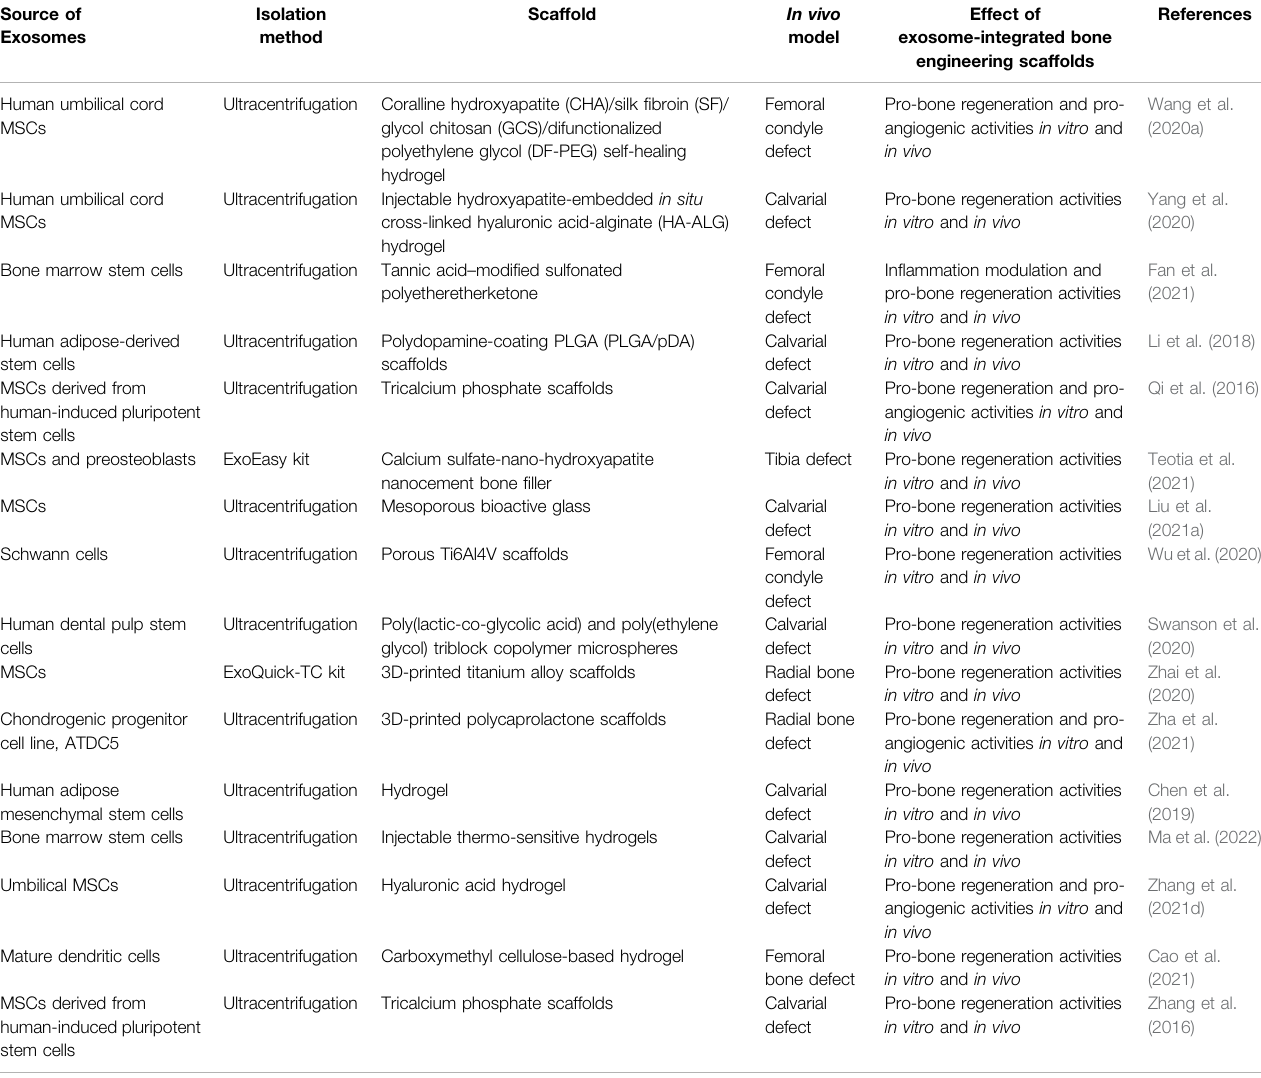
TABLE 2 | Summary of the applications of exosome-integrated bone engineering scaffolds in bone